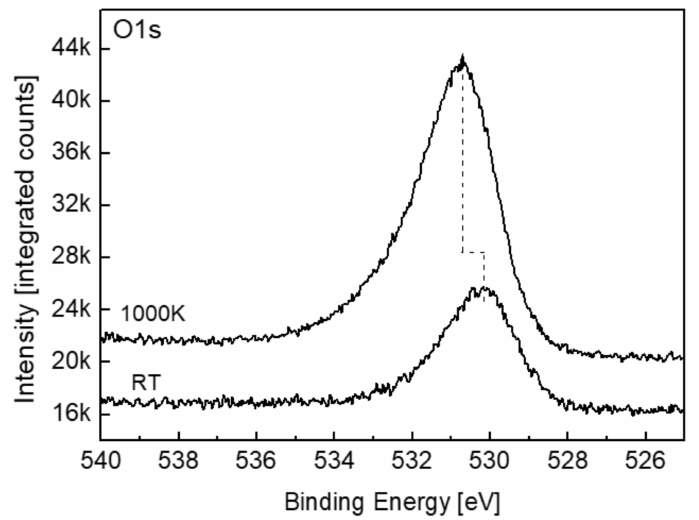
Figure 9. Oxide thickness formed on the surface during exposure to oxygen at RT and 1000 K.